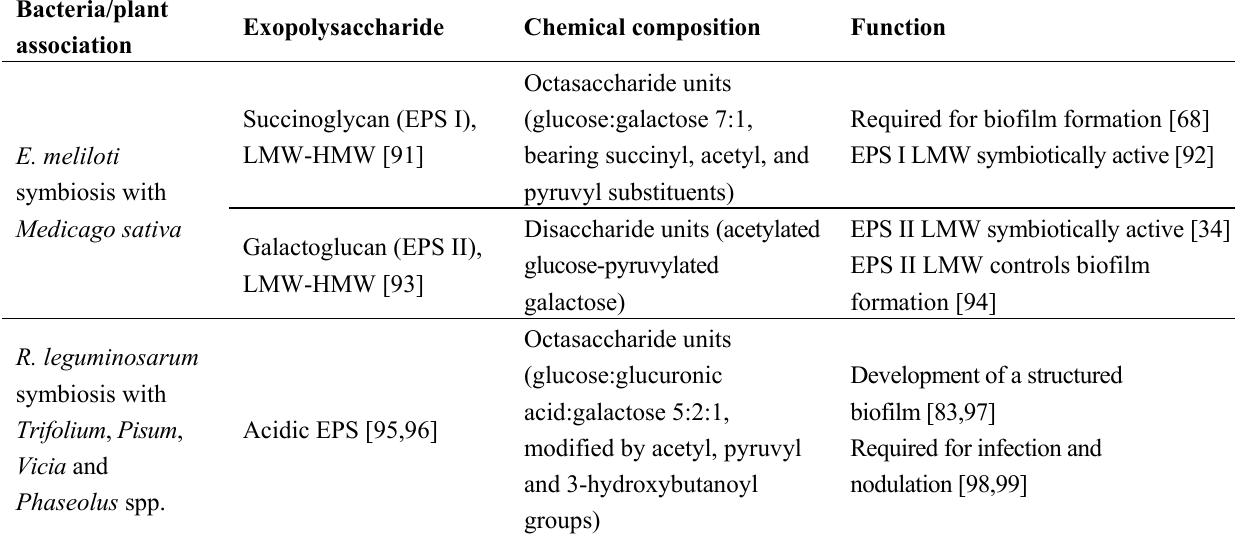
Table 1. Production, composition, and functional roles of exopolysaccharides (EPSs) in beneficial and pathogenic plant-associated